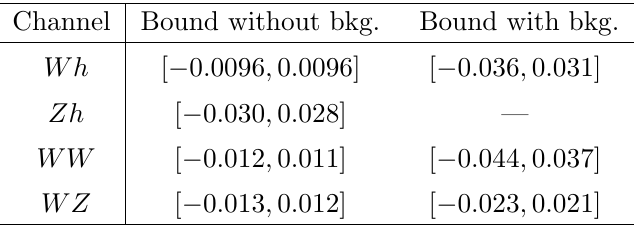
Table 5 . Bounds on a (3) q (in TeV (cid:0) 2 ) from the estimates of table